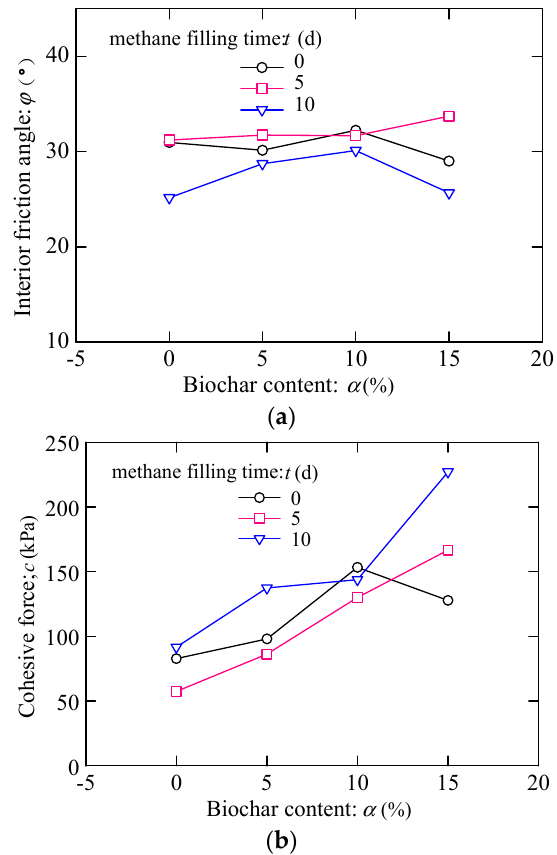
Figure 6. Cohesion force and friction angle of biochar–clay mixed soil with methanotrophs and various biochar content. ( a ) φ – α . ( b ) c – α .